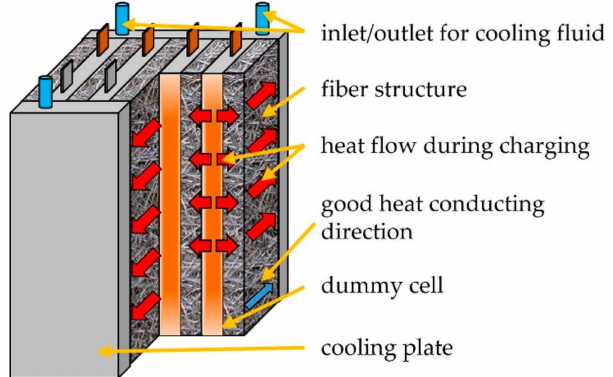
Figure 21. Schematic drawing of a battery with single battery cells stacked with PCM filled fiber structures. An orange arrow marks the heat flow direction during active cooling during fast charging.